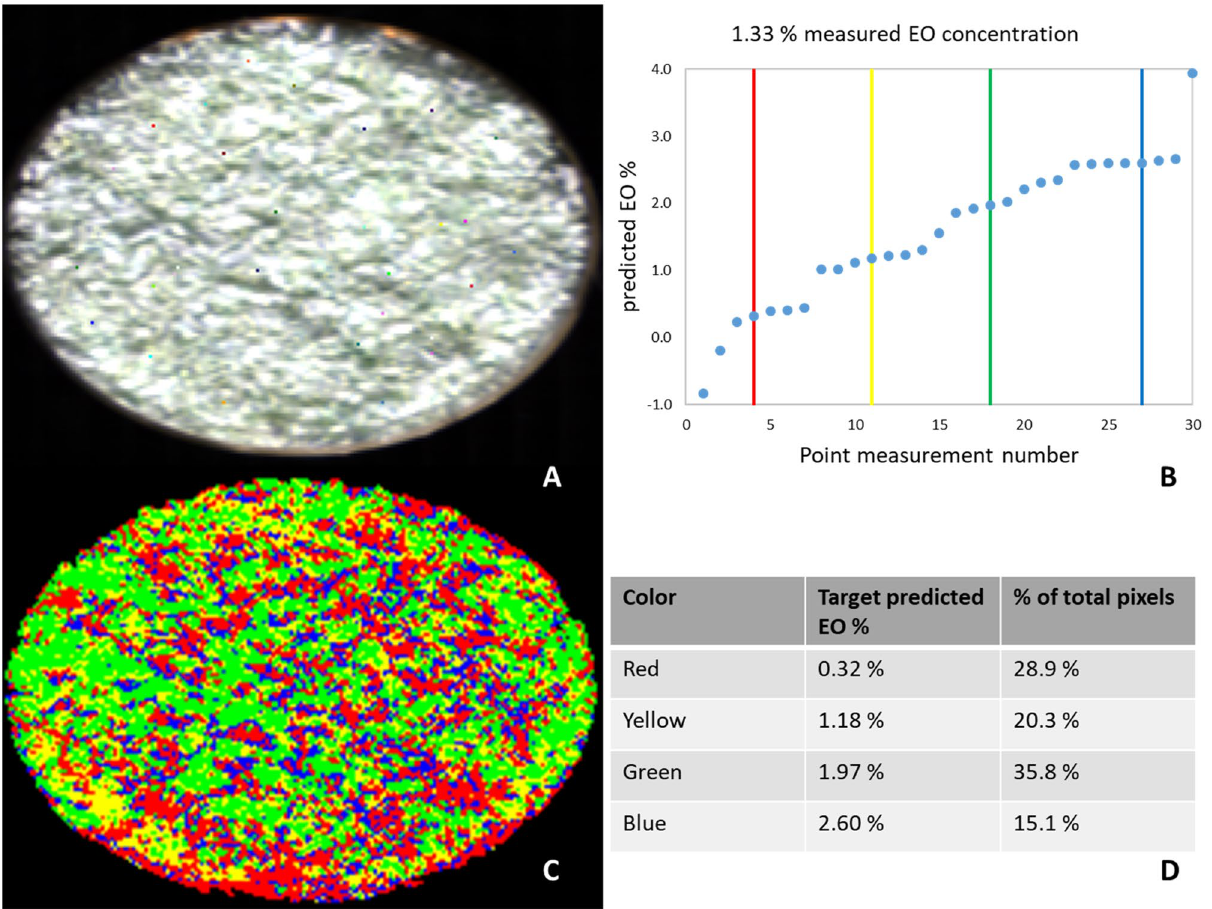
Figure 6. ( A ) Spearmint image (1.33% EO) with 30 selected point (pixel) measurements, shown as colored pixels. ( B ) Predicted EO % of the 30 selected points and the 4 selected target NIR spectra and associated predicted EO % represented as vertical lines in red, yellow, green and blue. ( C ) Image of the classification of all pixels into 1 of 4 categories (shown as differently colored pixels) based on resemblance of NIR spectrum at each pixel to the target spectra. ( D ) Information regarding the predicted EO % of the different color groups and the total percentage of pixels associated with each